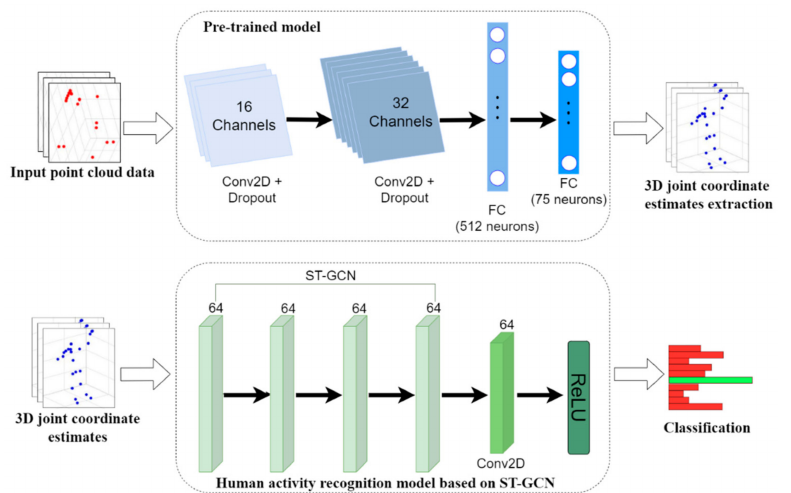
Figure 1. Our proposed model consists of a pre-trained model and ST-GCN. The pre-trained model, which is based on two consecutive convolution layers and two consecutive fully connected layers, extracts reliable features from the sparse point cloud data. These reliable features are obtained in the form of 25 human joints. The ST-GCN based model extracts additional features in the spatio-temporal domain from joint coordinate estimates and classifies human